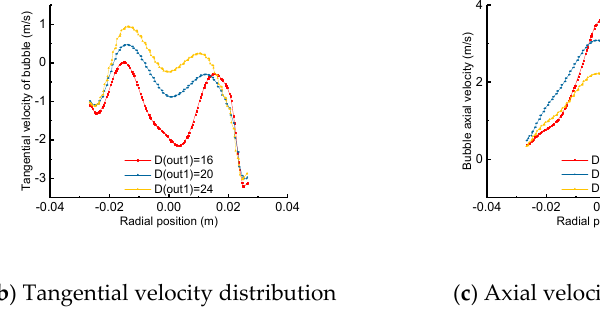
Figure 5. Section Z velocity distribution curve.